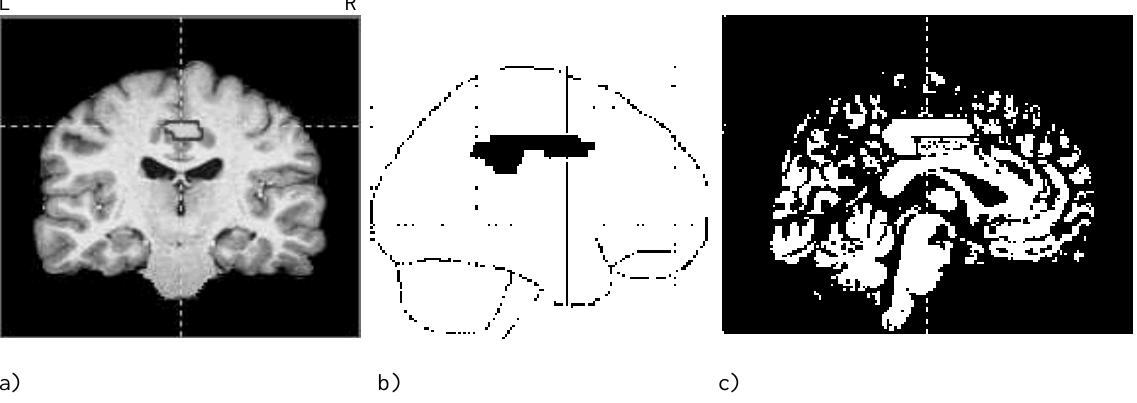
Fig. 2. A statistical parametric map of the significant area of decreased CBF (cingulate, K = 575 voxels, Z max = 3 . 19 , r = − 0 . 49 , ( x,y,z ) = − 4 , − 40 , 40 , BA 32 / 24 / 31 ) associated with increased negative symptom score (PANSS negative) in first episode schizophrenic patients is shown in Fig. 1(b). This is superimposed onto an anatomically standardised T1 MR image to facilitate visualisation (Figs (a) and